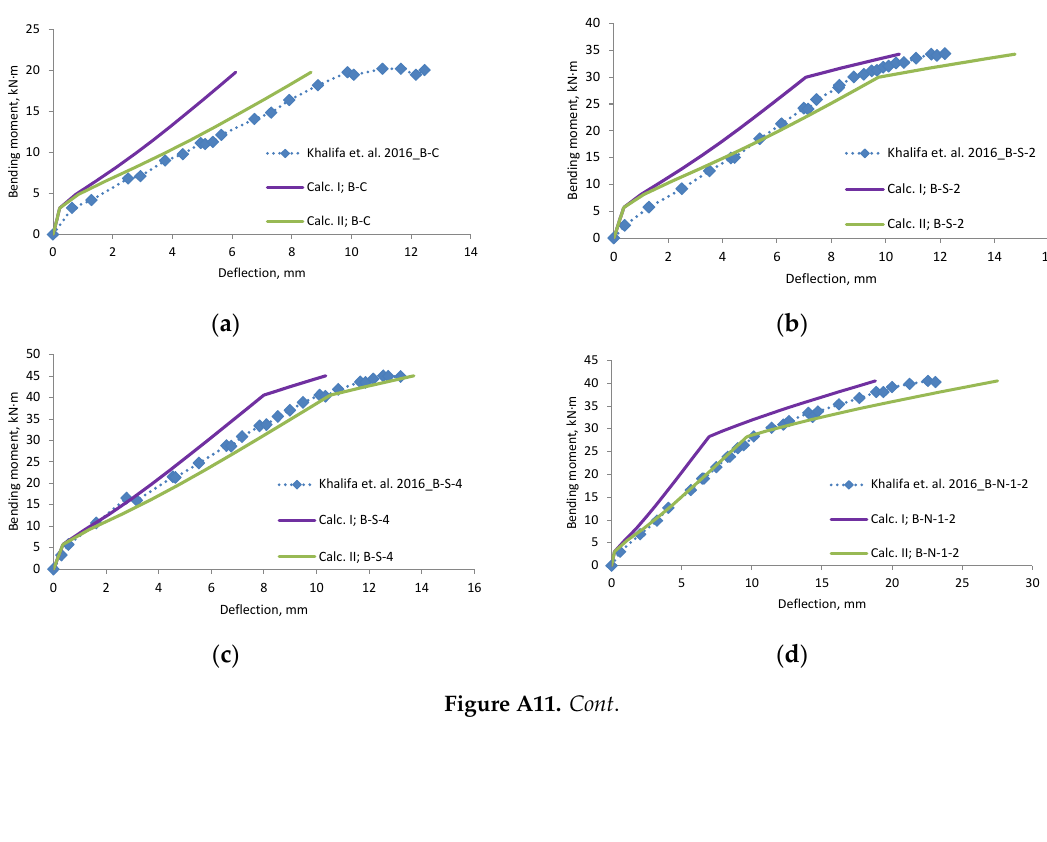
Figure A10. Hosseini et al., 2014 [33] research beams deflection compared with calculated, ( a ) beam SREF; ( b ) beam S2L-0; ( c ) beam S2L-20; ( d ) beam S2L-40; ( e ) scatter of the results at 60% and 80% of the ultimate load.